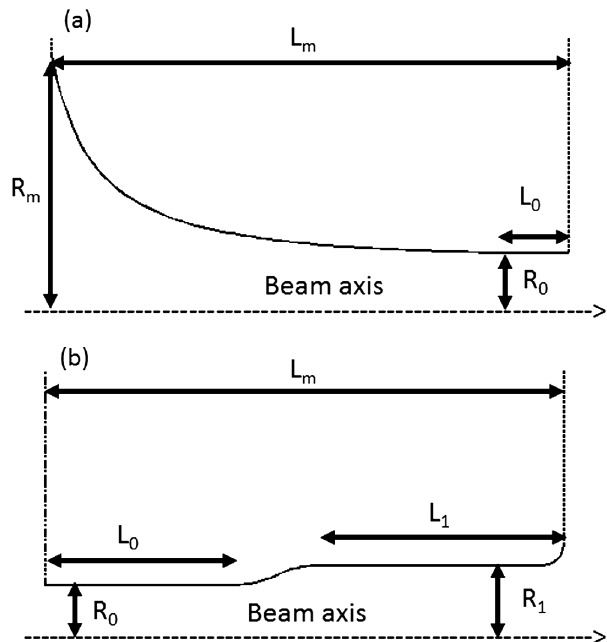
FIG. 2. Geometry of a standard input matcher (a) and the geometry of the new type of output matcher